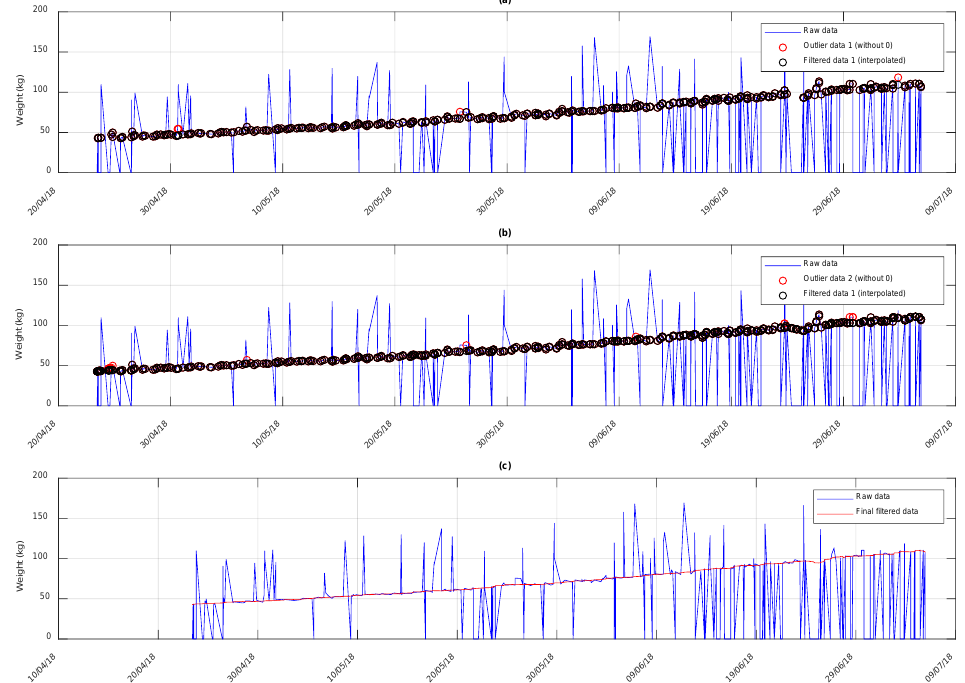
Figure 9. Filtration process of the weight scale records during the test for the animal with tag 6229: ( a ) original weight data and outliers detection by over a sliding window of length 10; ( b ) original weight data and outliers detection by over a sliding window of length 5; and ( c ) original weight data and adjustments results.